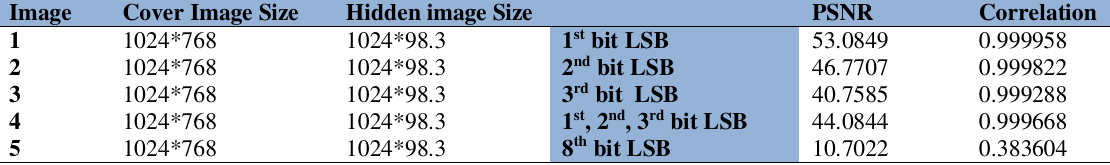
PSNR and correlation results for hidden secret color image of (98.3 KB)